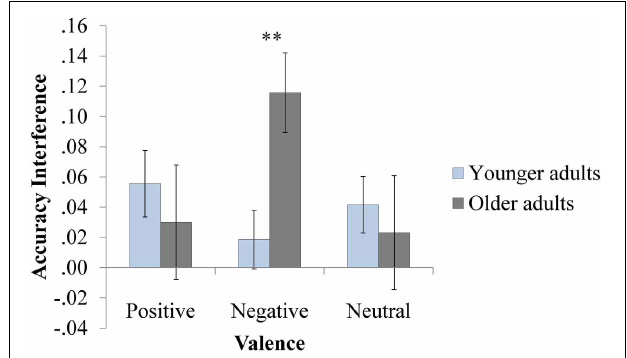
FIGURE 5 | Accuracy interference scores. Error bars represent standard errors. ∗∗ p < 0 .